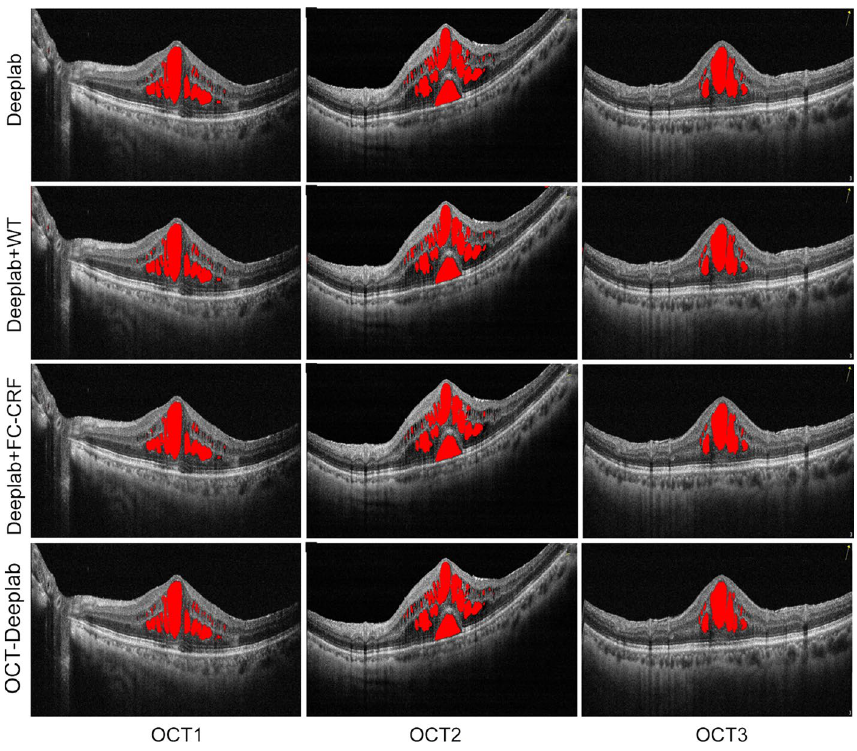
Figure 7. Different segmentation results of macular edema by Deeplab with different setting.